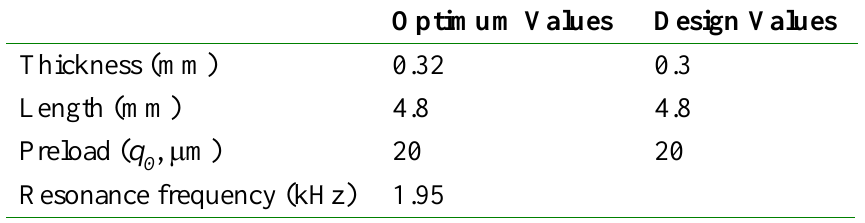
Table 2. Optimized results of parameters